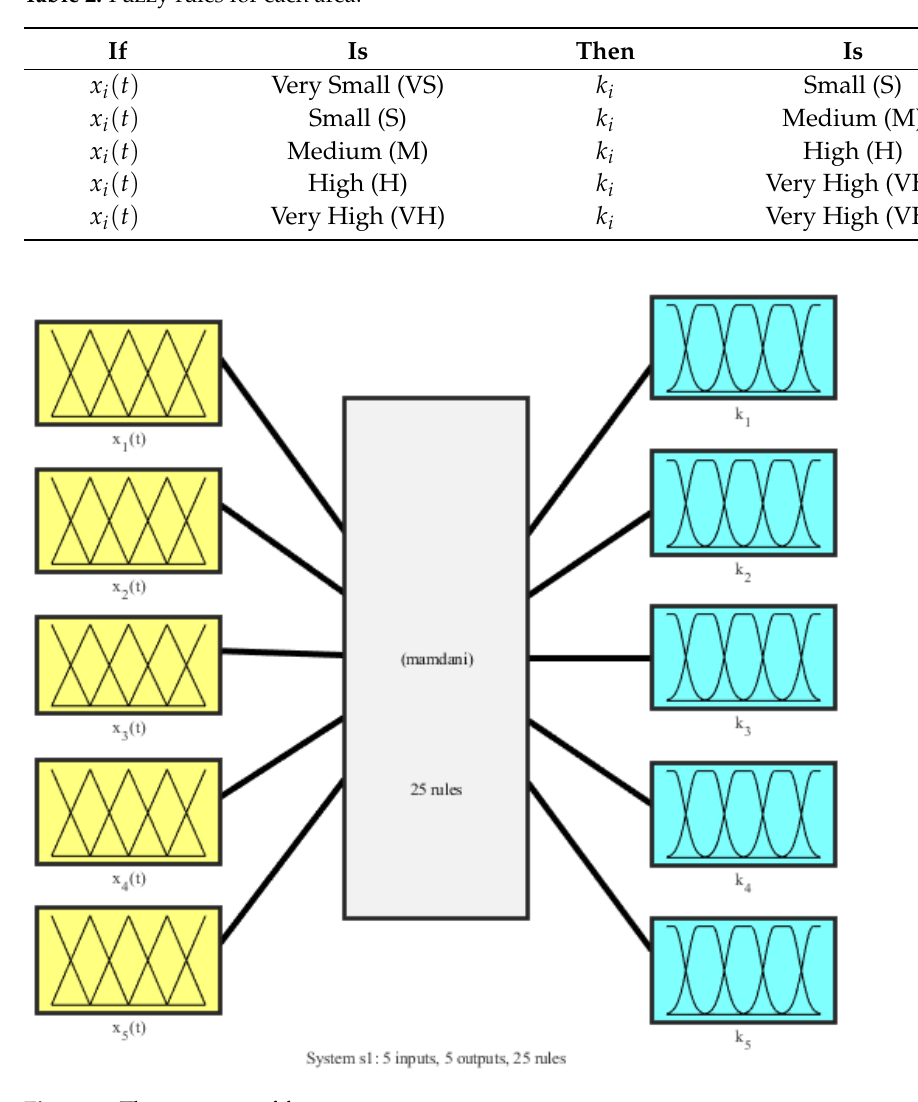
Figure 3. The structure of fuzzy